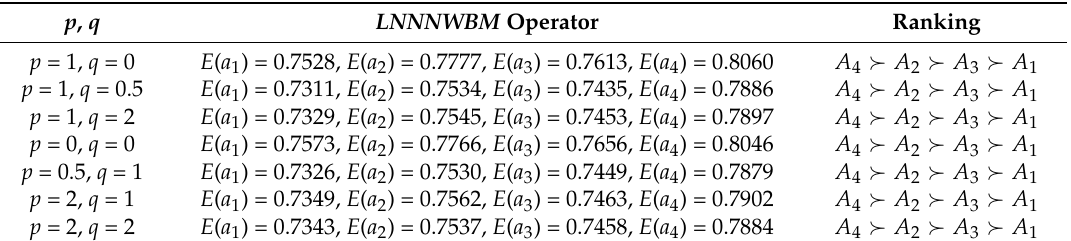
Table 6. The ranking based on the LNNNWBM operator with the different values of p and q . LNNNWBM Operator